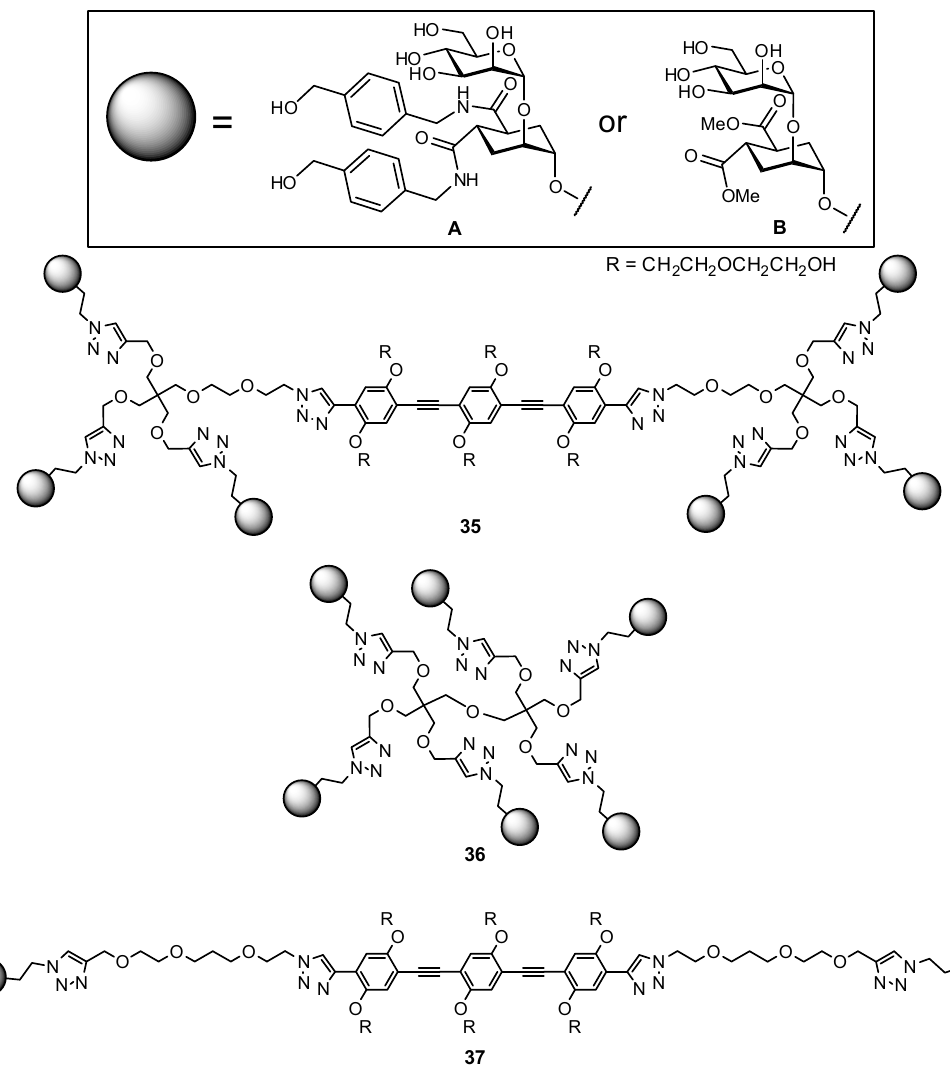
Figure 12. Multivalent constructs based on a DC-SIGN glycomimetic antagonist, used to probe the effects of chelation versus statistical rebinding multivalency effects [93] .